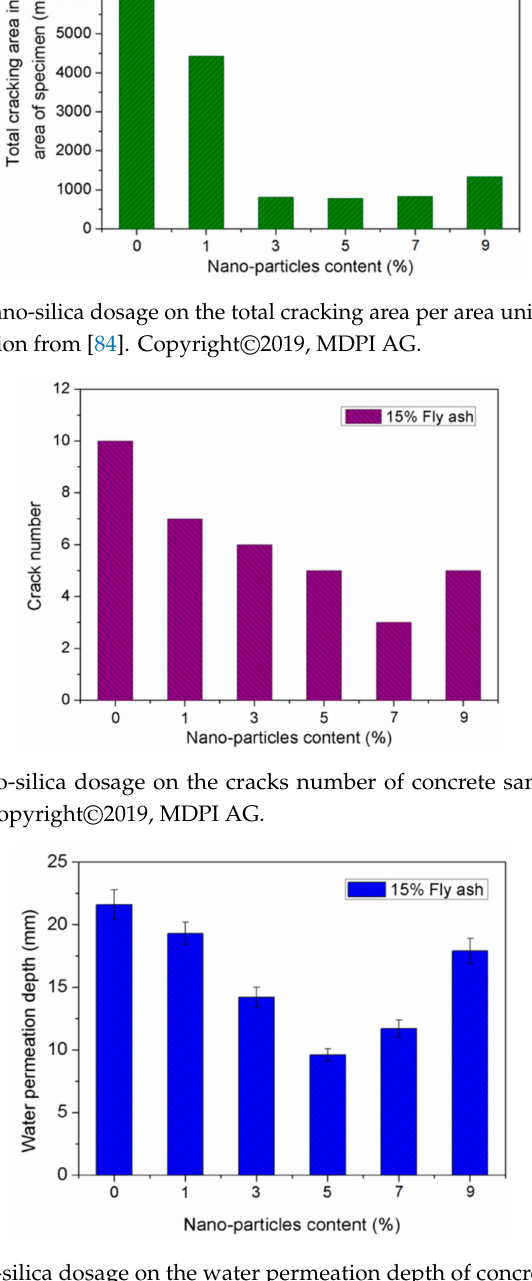
Figure 7. E ff ect of nano-silica dosage on the water permeation depth of concrete samples. Reprinted with permission from [84]. Copyright © 2019, MDPI